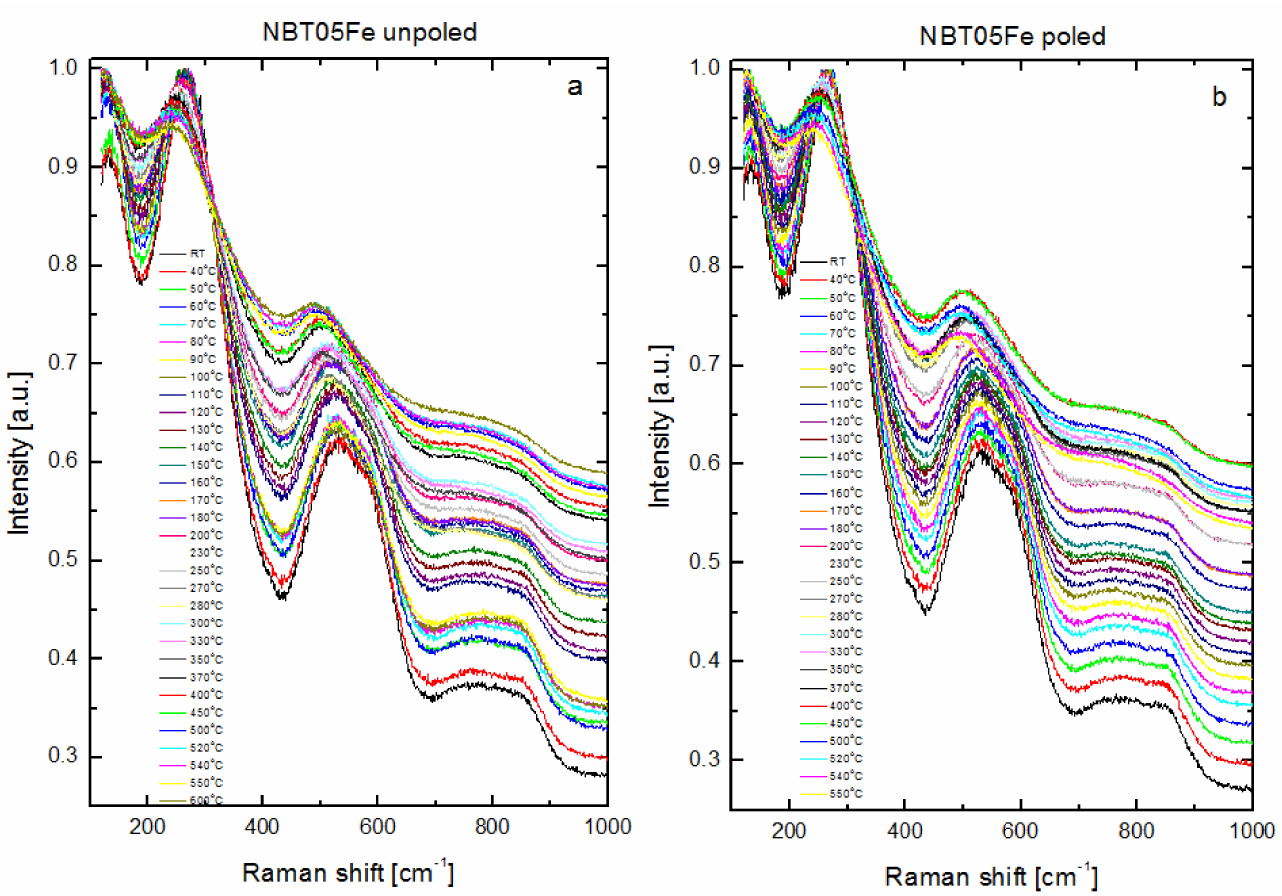
Figure 8. Temperature evolution of Raman spectra of NBT05Fe in ( a ) unpoled and ( b ) poled